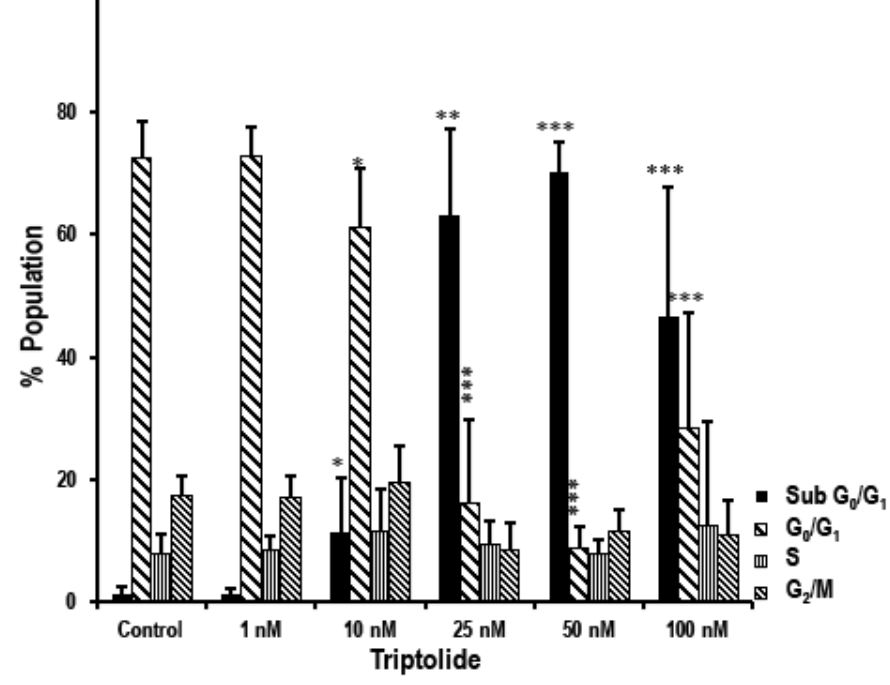
Figure 4. The effect of varying concentrations of triptolide on cell cycle. Bar diagram presents the cell cycle analysis of MDA-MB-231 cells. The population of cells, based on the florescent peaks, were grouped under sub G 0 /G 1 , G 0 /G 1 , S, G 2 /M phase. Untreated cells were used as controls. The MDA-MB-231 cells after 72 h of treatment with triptolide showed marked increase in the sub G 0 /G 1 phase (in 10 nM and above), indicating an increase in cell death/apoptosis, and the proportion of cells in the G 0 /G 1 phase decreased in comparison to the control. The values are represented as mean ± SD. *, p -value < 0.05; **, p -value < 0.001; ***, p -value < 0.0001. The S phase and G 2 /M phase did not show significant change under any treatment condition.